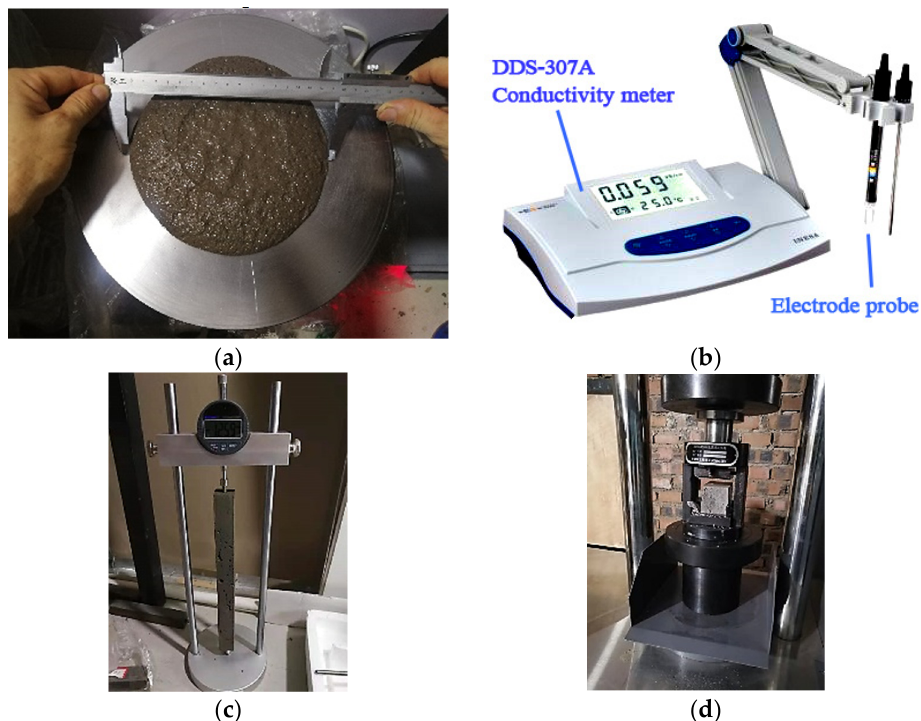
Figure 2. The experiments of ( a ) fluidity, ( b ) conductivity, ( c ) drying shrinkage, and ( d ) mechanical strength.